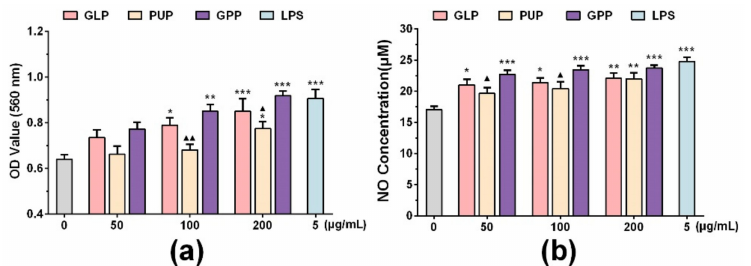
Figure 1. The e ff ect of Ganoderma lucidum polysaccharides (GLP), Polyporus umbellatus polysaccharides (PUP) and a polysaccharide composition consisting of GLP on phagocytosis and NO production in RAW264.7 cells, respectively. ( a ) Phagocytosis of macrophages was detected by neutral red assay. ( b ) The release of nitric oxide (NO) was detected by Griess assay in macrophages. Data were expressed as mean ± SEM, * p < 0.05, ** p < 0.01, *** p < 0.001 vs. control group, (cid:78) p < 0.05, (cid:78)(cid:78) p < 0.01 vs. GPP group.